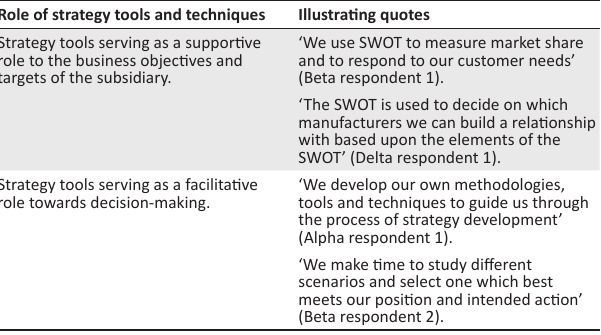
TABLE 3: Role of strategy tools and techniques in competitive intelligence. Role of strategy tools and techniques